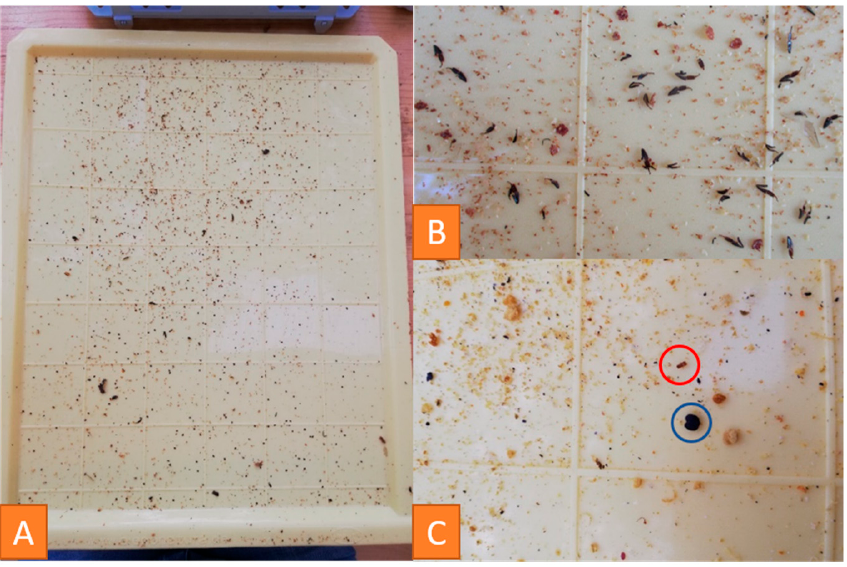
Figure 5. Photographs of a plastic drawer after three days under the hive of an Apis mellifera carnica colony in September with debris containing a lot of Varroa mites ( A ), separated legs and wings of bees ( B ), pollen (blue cycle) and wax cylinders (red cycle) ( C ). © Julia Dittes.